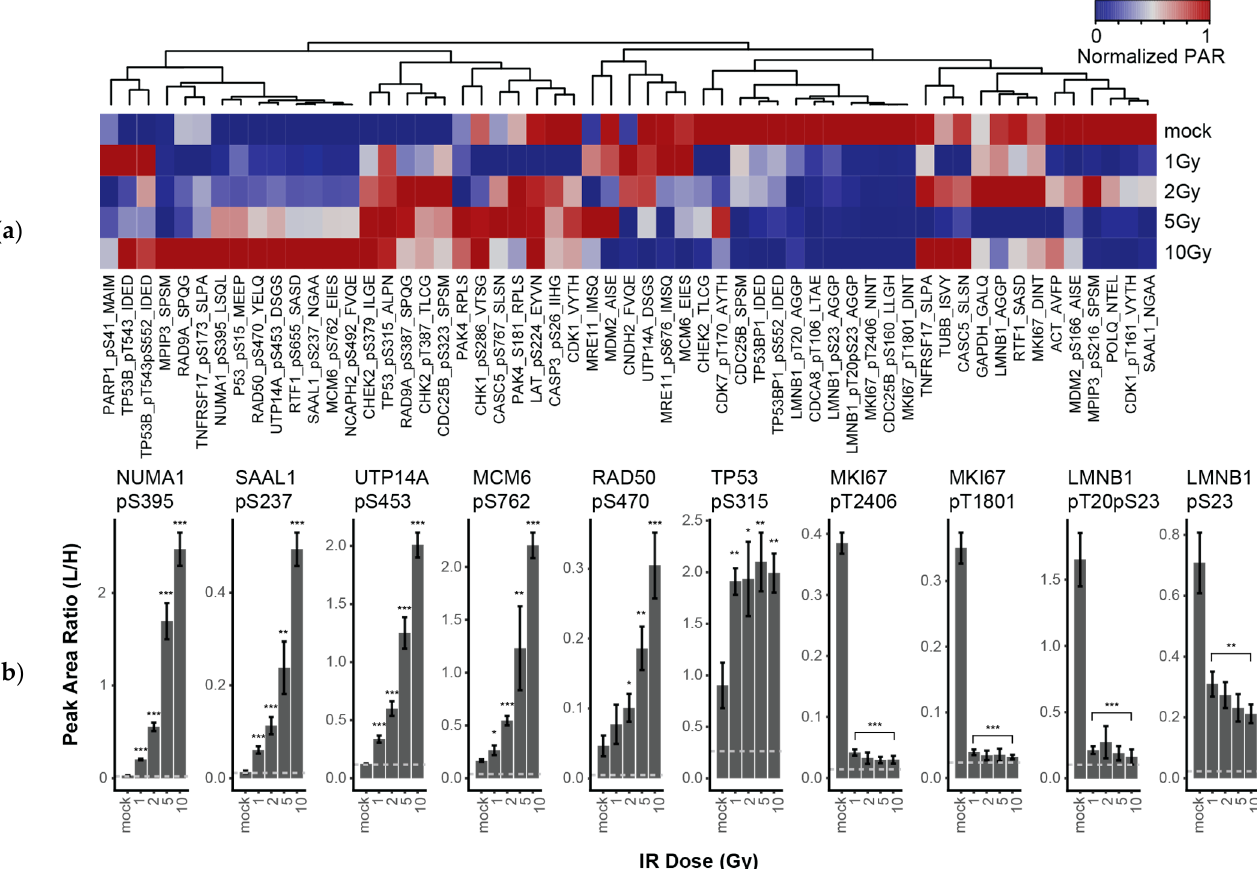
Figure 2. The DDR-2 immuno-MRM assay detects changes in phosphorylation in response to ionizing radiation. ( a ) Heatmap showing unsupervised clustering of analytes detected in LCL-57 exposed to increasing levels of irradiation (1,2,5,10 Gy); control samples were mock-irradiated. All samples were harvested at 1 h. Peak area ratios (light:heavy) were normalized for each peptide analyte. Peptide analyte labels indicated gene symbol, followed by modification site and the first four letters of the peptide sequence. Nonmodified peptides are indicated by “pan”. ( b ) Bar plots showing peak area ratio (light:heavy) of analytes with greater than 2-fold change in concentration detected by immuno-MRM. Error bars show the standard deviation of biological triplicate analysis. In t-test between irradiated and mock results, one asterisk (*) indicates p value smaller than 0.05 ( p < 0.05); two asterisks (**) indicate p value smaller than 0.01 ( p < 0.01); three asterisks (***) indicate p value smaller than 0.001 ( p < 0.001).